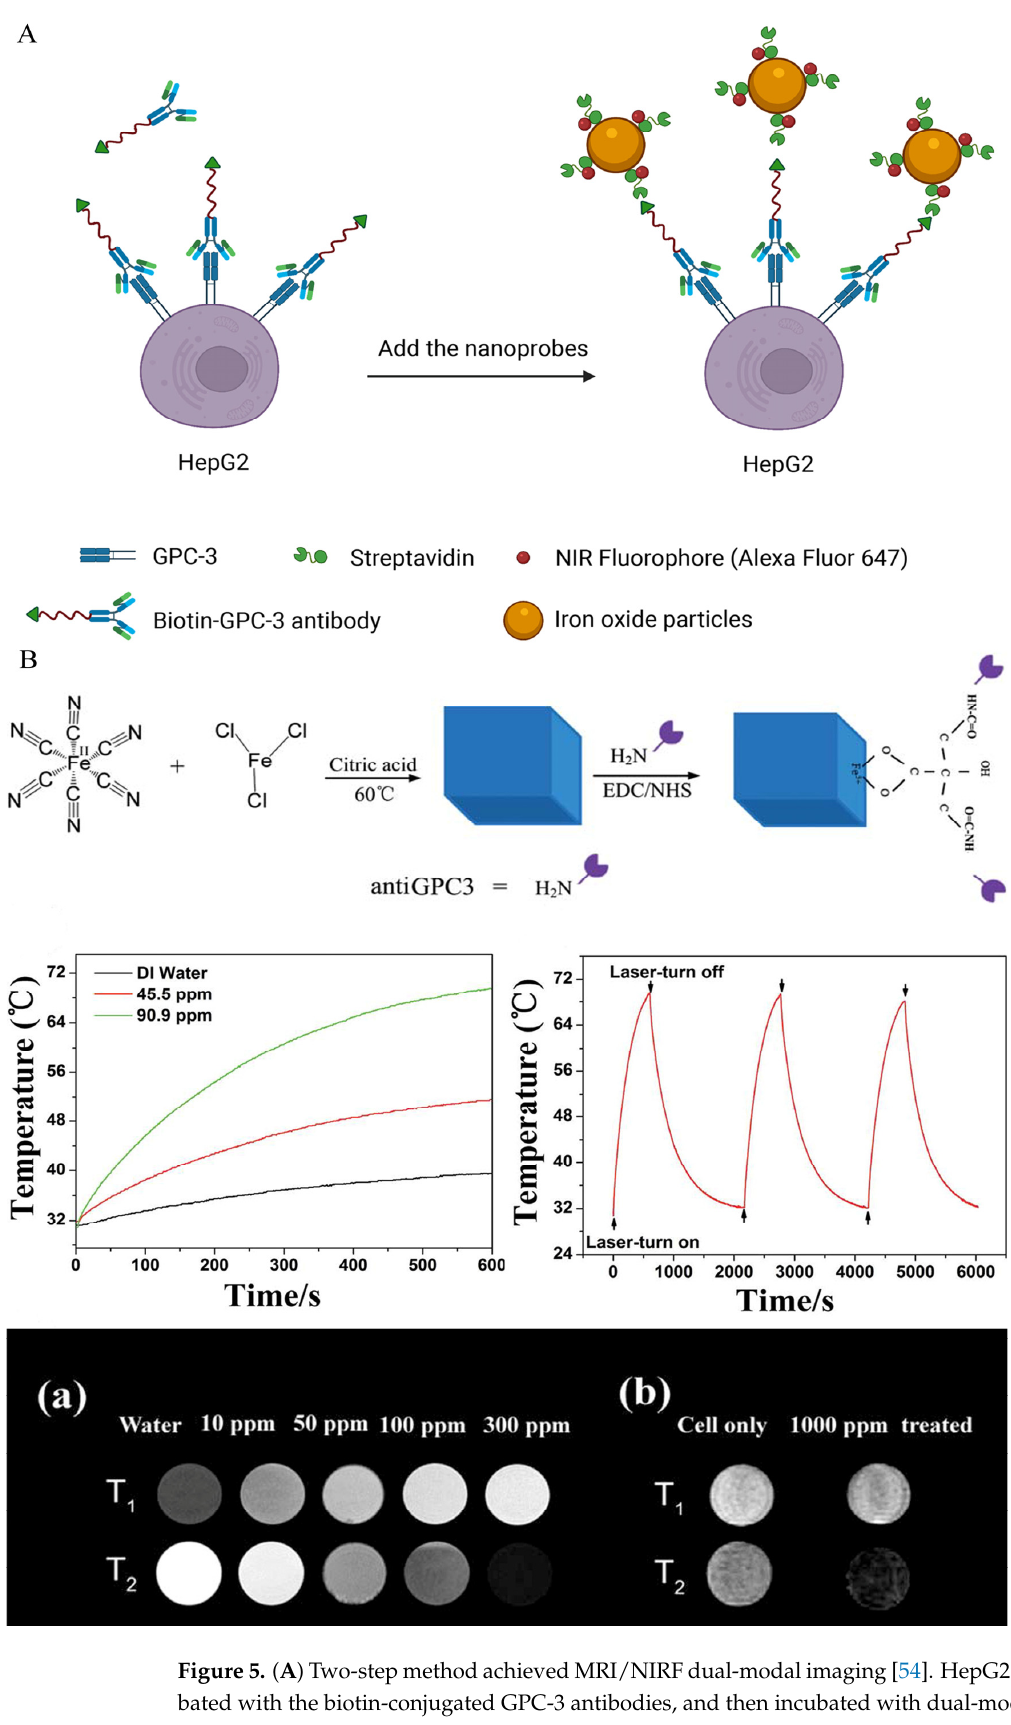
Figure 5. ( A ) Two-step method achieved MRI/NIRF dual-modal imaging [54]. HepG2 cells were incu- bated with the biotin-conjugated GPC-3 antibodies, and then incubated with dual-modal